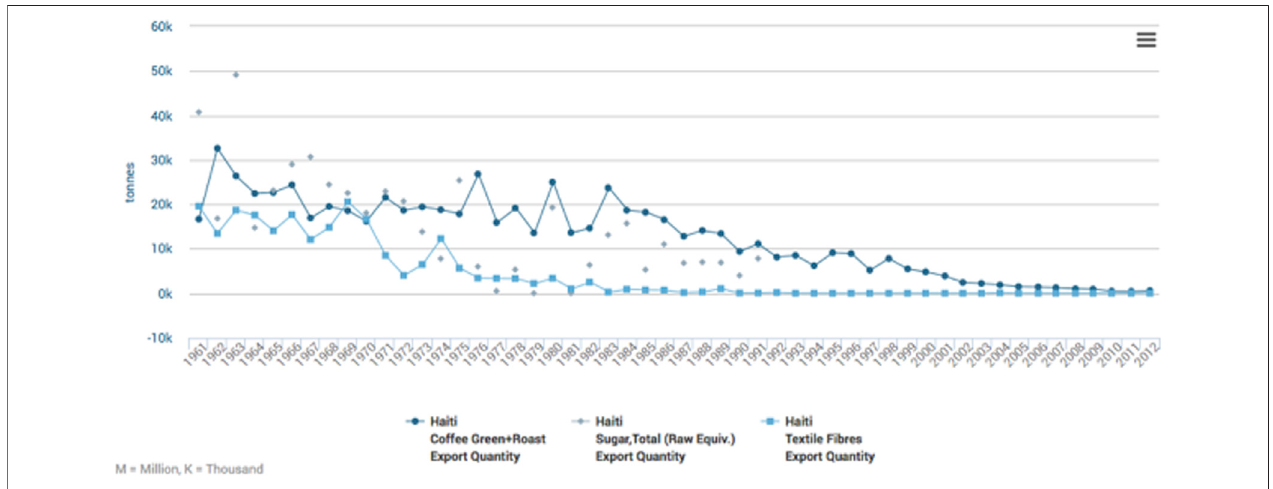
FIGURE 3 | Haiti, declining exports - coffee, sugar, sisal (1961 –